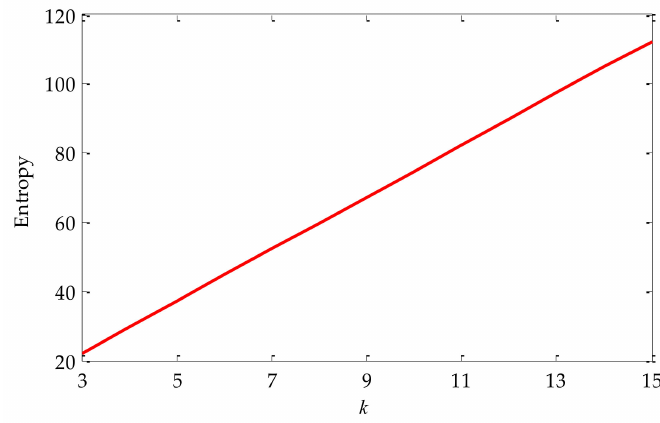
Figure 37. Curve of fitness varying with k value.